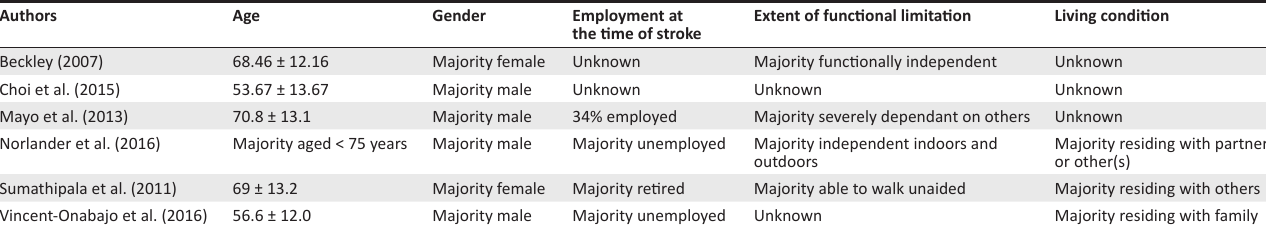
TABLE 3: Demographic